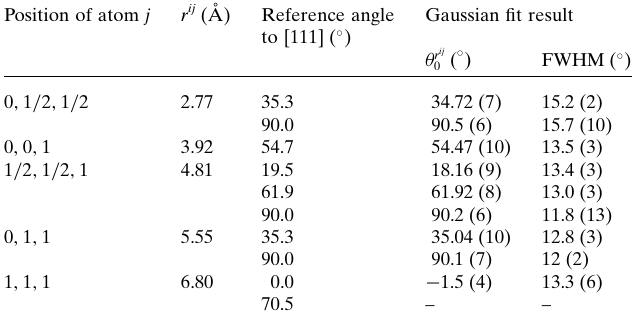
Table 2 Real-space fiber-plot peak fit results. The interatomic vectors from atom i to atom j are represented in terms of components using a basis of the crystallographic lattice vectors and assuming that the origin is placed on atom i . Furthermore, r ij is the distance between atom i and atom j , and (cid:5) r ij is the fitted peak position. 0 Position of atom